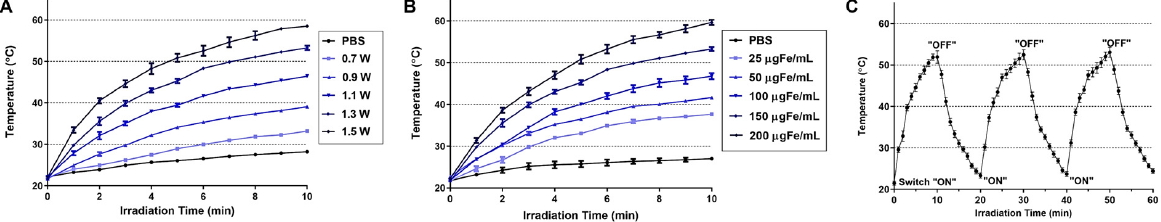
Figure 4. In vitro assessment of the light-to-heat conversion efficiency of Lipo-IONP. Temperature profiles of Lipo-IONP suspensions after laser irradiation ( A ) at different laser powers with fixed particle concentrations (150 μ gFe/mL) and ( B ) at different particle concentrations with fixed laser power (1.3 W). ( C ) The stability of the Lipo-IONP’s photothermal activity was evaluated by monitoring the suspension temperature after laser irradiation for three cycles by a switch “on” and “off” mode (10 min for each mode in every cycle) (Lipo-IONP: liposomal iron oxide nanoparticle).